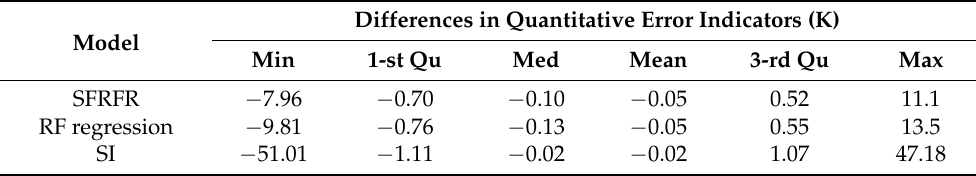
Figure 9. Importance score rankings of the model results: ( a ) RF regression and ( b ) SFRFR. 3.4. Performance of Reconstructed Gap-Free LST from 2016 to 2021 The original images representing the summertime LST from 2016 to 2021 were recon- structed using the proposed model. Figure 10 presents the variations in the urban thermal environment over the past six years. Generally, the thermal emissions showed a decreas- ing trend from the city centers to the suburbs, and the highest temperature occurred in